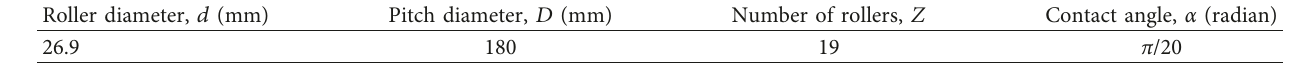
Table 3: Characteristic frequencies.